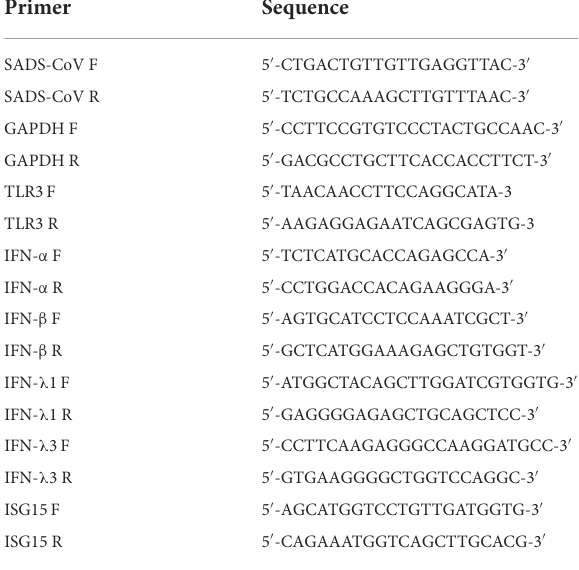
TABLE 1 The primers used for qRT-PCR in this